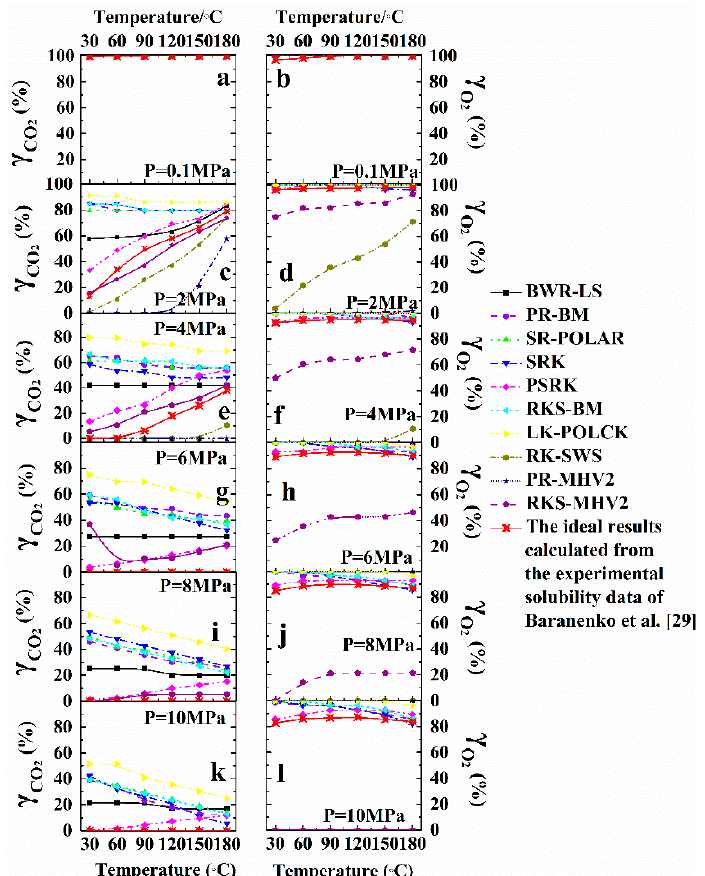
Figure 5. Comparisons of the ideal results calculated from the experimental solubility data and simulation results at different pressures and temperatures, ( a ) γ O2 at P = 0.1 MPa, ( b ) γ CO2 at P = 0.1 MPa, ( c ) γ O2 at P = 2 MPa, ( d ) γ CO2 at P = 2 MPa, ( e ) γ O2 at P = 4 MPa, ( f ) γ CO2 at P = 4 MPa, ( g ) γ O2 at P = 6 MPa, ( h ) γ CO2 at P = 6 MPa, ( i ) γ O2 at P = 8 MPa, ( j ) γ CO2 at P = 8 MPa, ( k ) γ O2 at P = 10 MPa, ( l ) γ CO2 at P = 10 MPa.